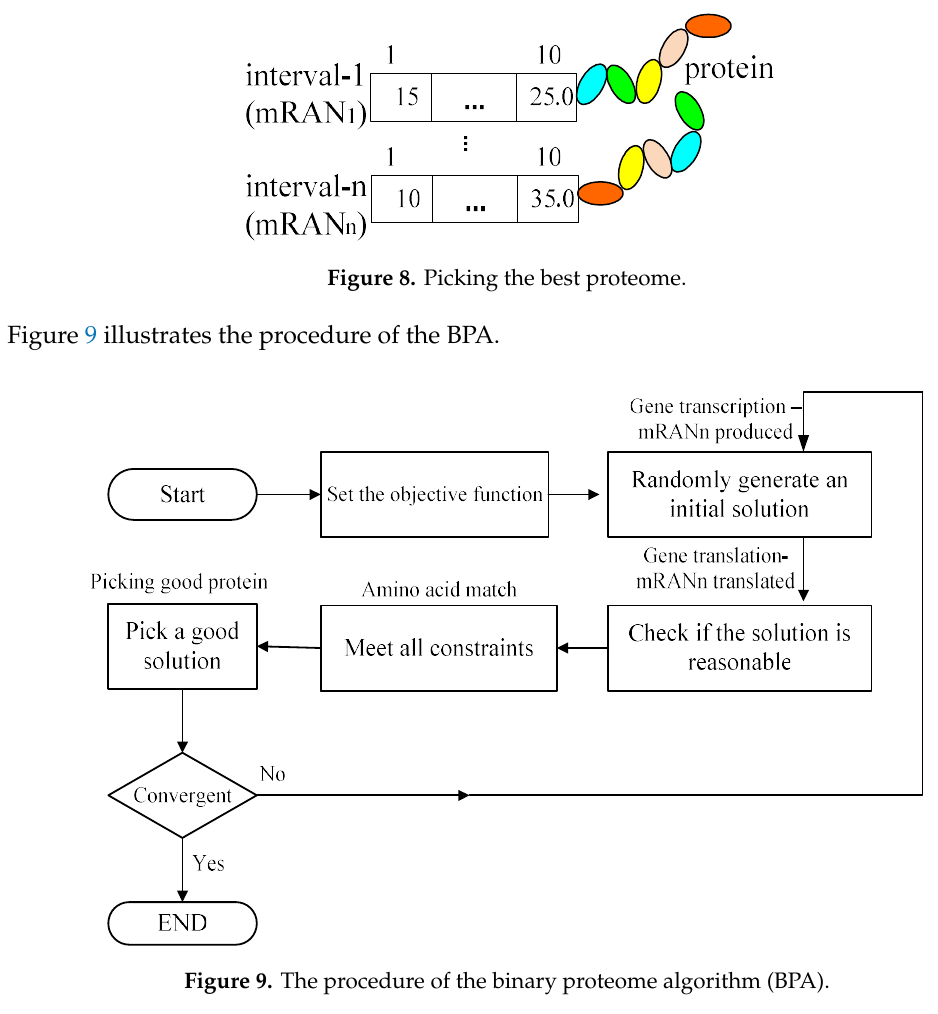
Table 2. The load change of refrigerating chamber (kW).